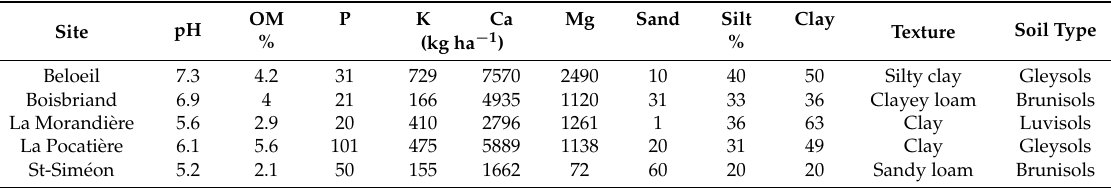
Table 1. Soil Physical and Chemical Characteristics at the Time of Establishment for Five short-rotation coppice (SRC)-Willow